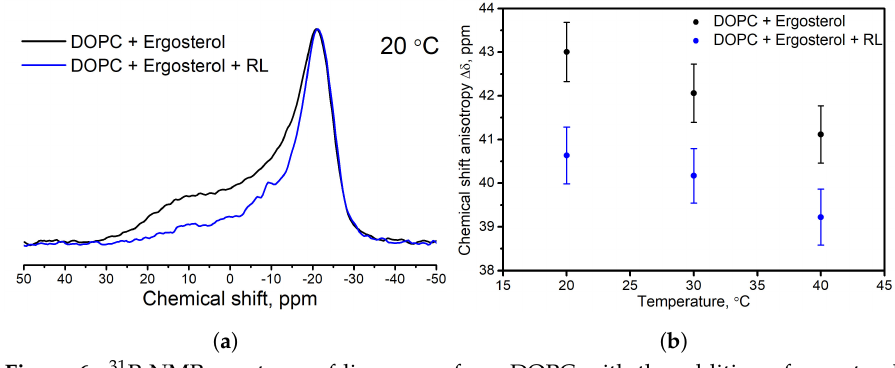
Figure 6. 31 P NMR spectrum of liposomes from DOPC with the addition of ergosterol without rhamnolipids (black solid libe) and with an aqueous injection of rhamnolipids (blue solid line) at a temperature of 20 ◦ C ( a ). Dependence of CSA values ∆ δ on temperature ( b ).